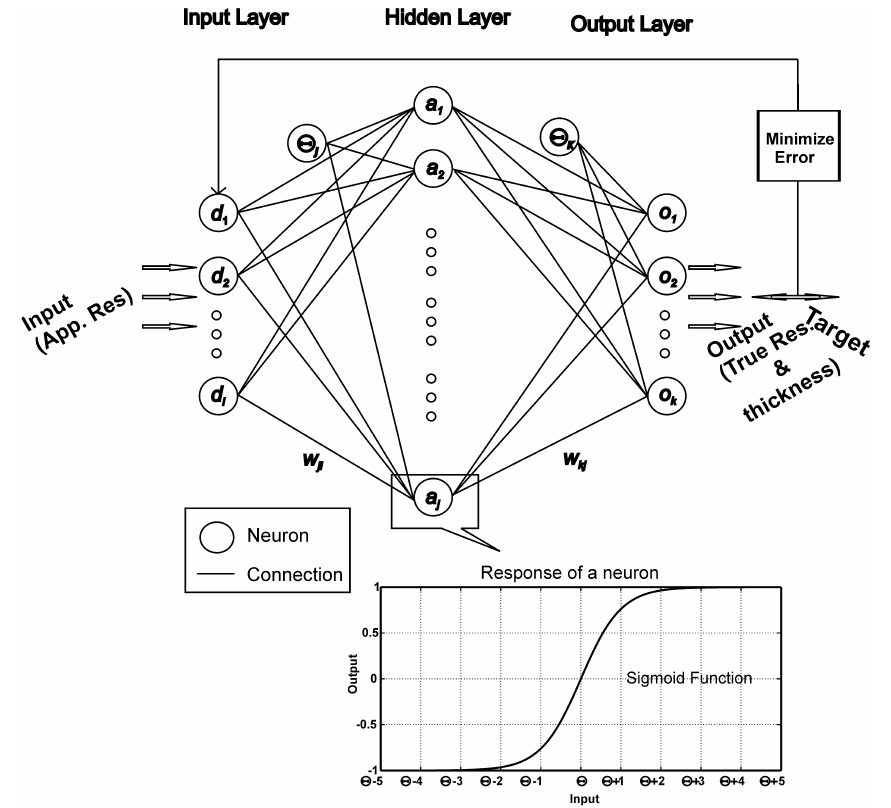
Fig. 2. Layout of MLP with a three-layer neural network with “ d ” representing input, subscript “ i ” representing the number of nodes in the input layer w ji representing the connection weight between the i -th node in the input layer and the j -th node in the hidden layer and w jk , representing the connection weight between the j -th node in the hidden layer and the k -th node in the output layer. 2 j and 2 k are bias vectors for the hidden and the output layer. When the sum of the argument of a neuron is comparable to the threshold value 2 j , the sigmoid function squashes linearly, otherwise it saturates with value +1; –1 gives non-linearity for non-linear mapping between an input and an output space. Sigmoid function plays key role for mapping non-trivial geo-electrical